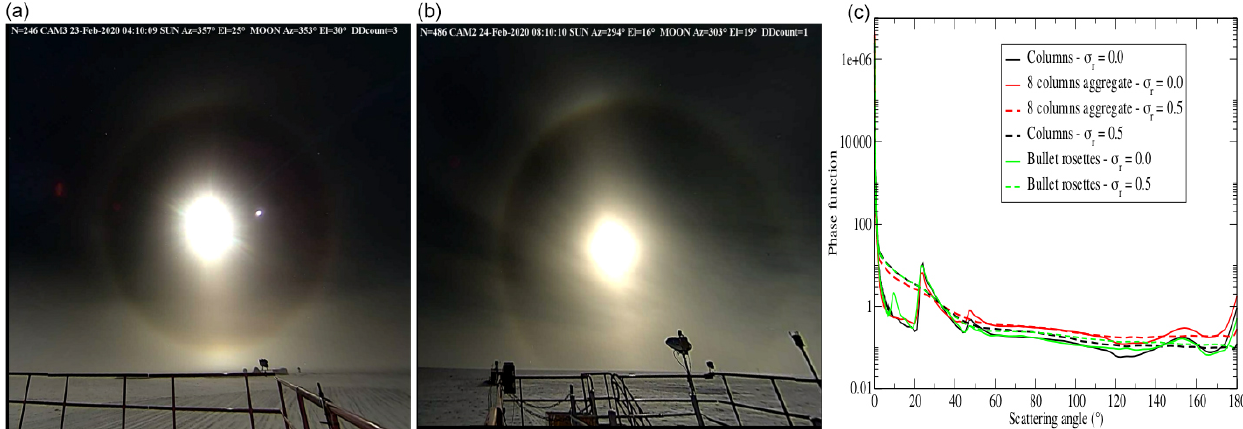
Figure 22. HALO-CAMERA images for the days of 23 (a) and 24 (b) February 2020. On panel (c) , the simulated phase functions at 532nm for the three habits considered with roughness σ r = 0 (smooth crystal surface) and σ r = 0.5 (severe rough crystal surface).